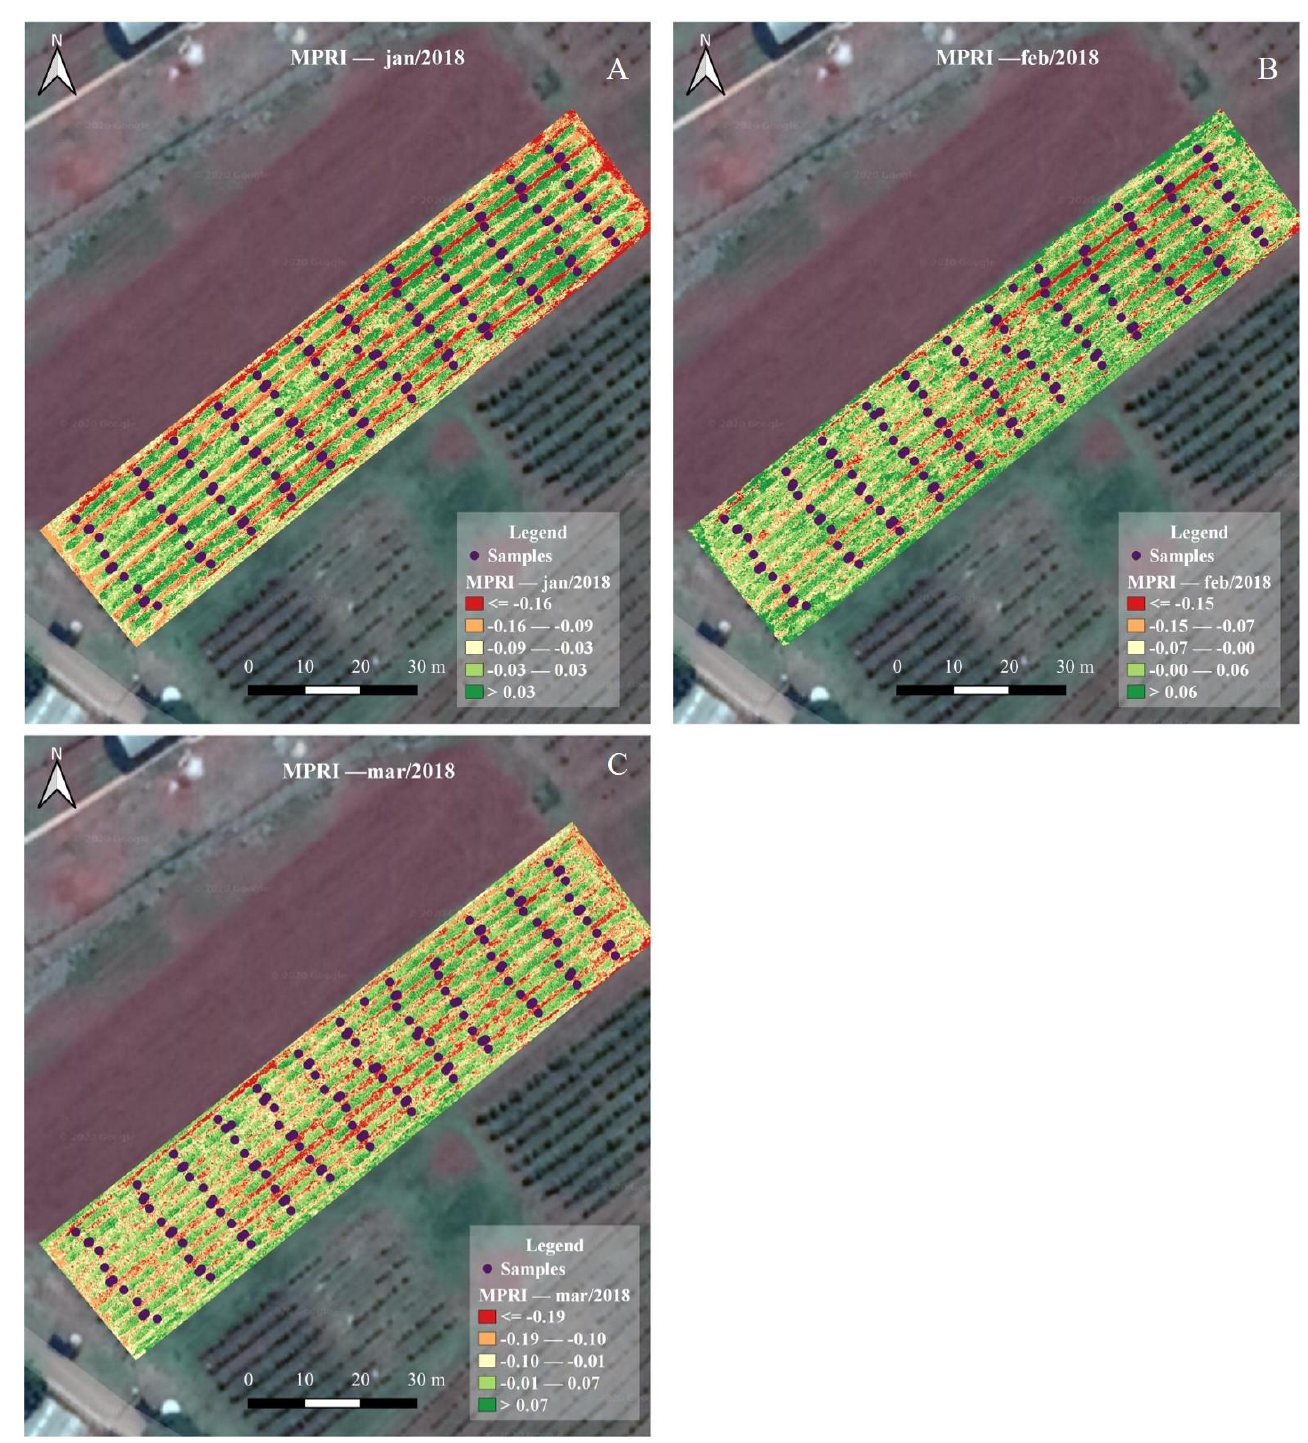
Figure 9. Fourth phase of the vegetative cycle of coffee evidenced by MPRI: ( A )—MPRI/january, ( B )—MPRI/february, ( C )—MPRI/march.